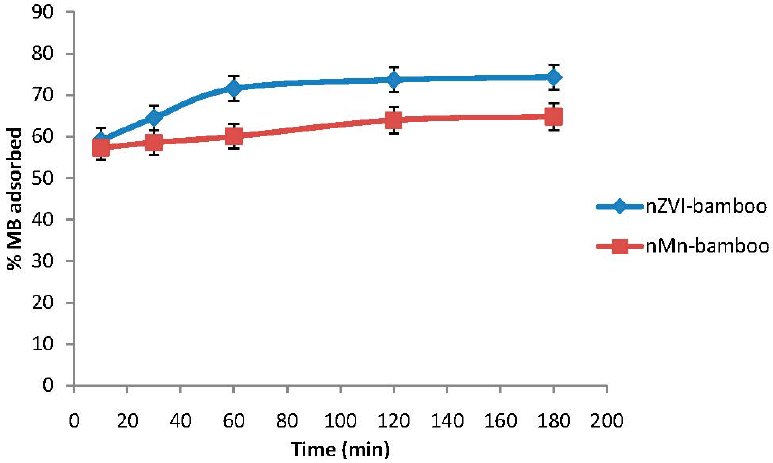
= 140 mg/L, T = 32 ± 2 °C at 165 0